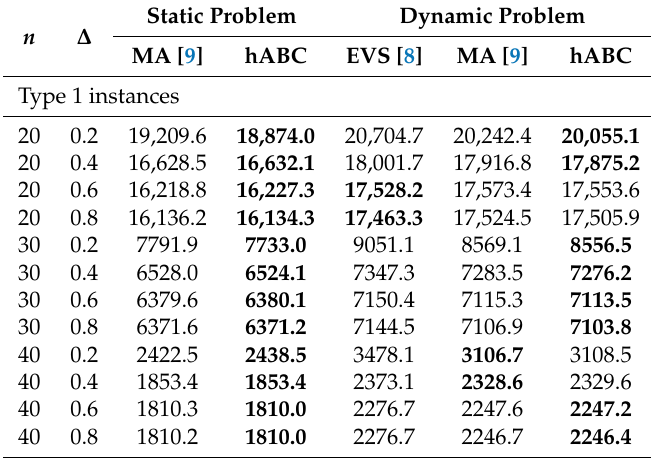
Table 4. Comparison of hABC to the state-of-the-art methods on the instances of scenario 3. The best values obtained for each set of instances are remarked in